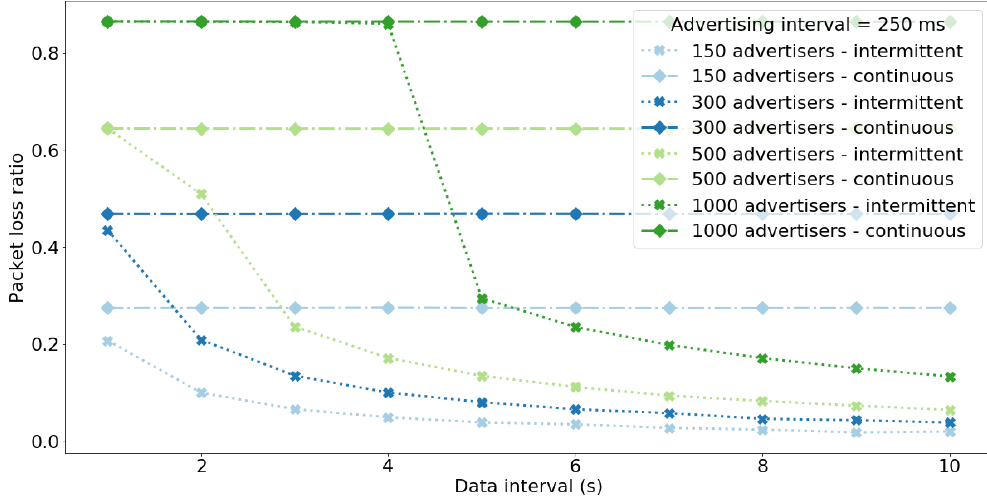
Figure 9. Median of the PLR for different data intervals τ , network sizes, and the advertisement interval equal 250ms. The PLR for large networks and short data intervals is the same for nodes operating both in continuous and intermittent